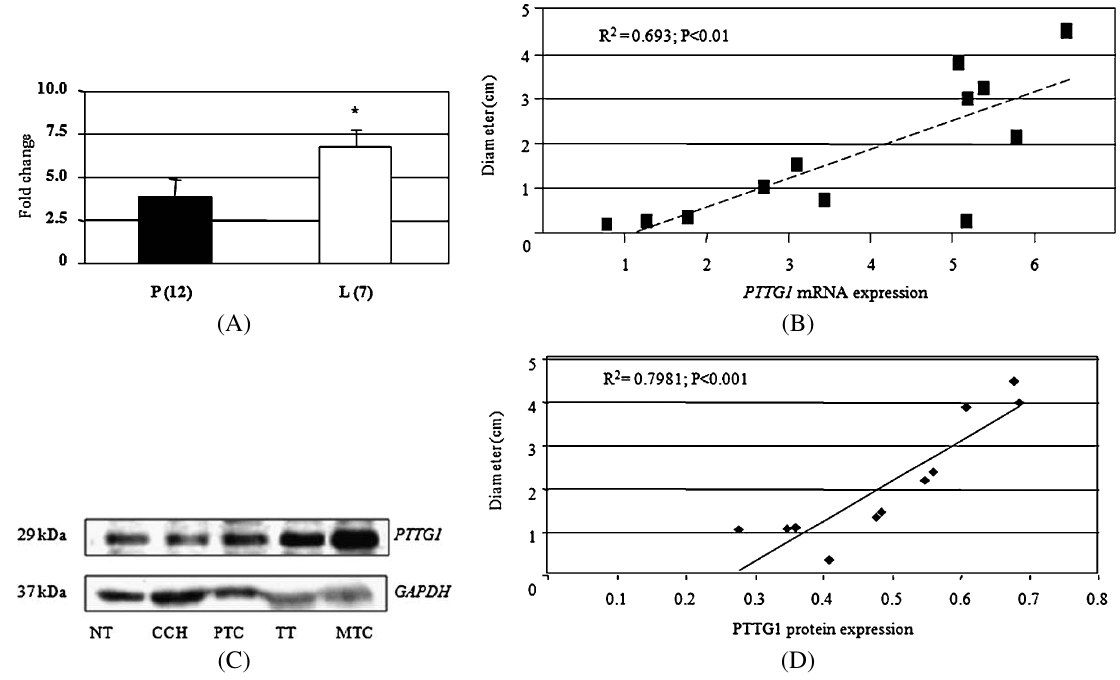
Fig. 2. PTTG1 mRNA and protein expression in human MTC. (A) Mean PTTG1 mRNA expression in 12 MTC primary thyroid lesions (P) and in 7 MTC lymph node metastases (L) expressed as fold change vs. normal thyroid tissue ± SE. ∗ p < 0 . 05 PTTG1 mRNA expression in L vs. P. (B) Correlation between MTC tumour diameter (cm) and PTTG1 mRNA expression (Arbitrary units). (C) PTTG1 protein levels. Representative Western blot analysis for PTTG1 and GAPDH protein expression in normal thyroid (NT), C-cell hyperplasia (CCH), papillary thyroid carcinoma (PTC), TT cells and in medullary thyroid carcinoma (MTC) samples. Whole cell extracts (80 µg) from each sample were fractionated on 12.5% SDS-PAGE, transferred on nitrocellulose membrane and incubated with an anti-PTTG1 antibody and, after stripping, with an anti-GAPDH antibody. (D) Correlation between MTC tumour diameter (cm) and PTTG1 protein levels (Arbitrary